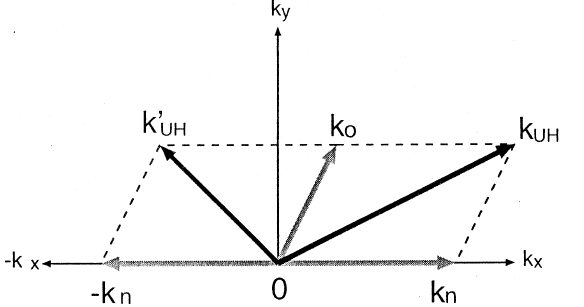
Fig. 6. Schematic illustration of the matching condition in the 2D wave number space. The wave number of the excited wave k UH is determined by the wave number of the pump wave k o and that of the density irregularity k